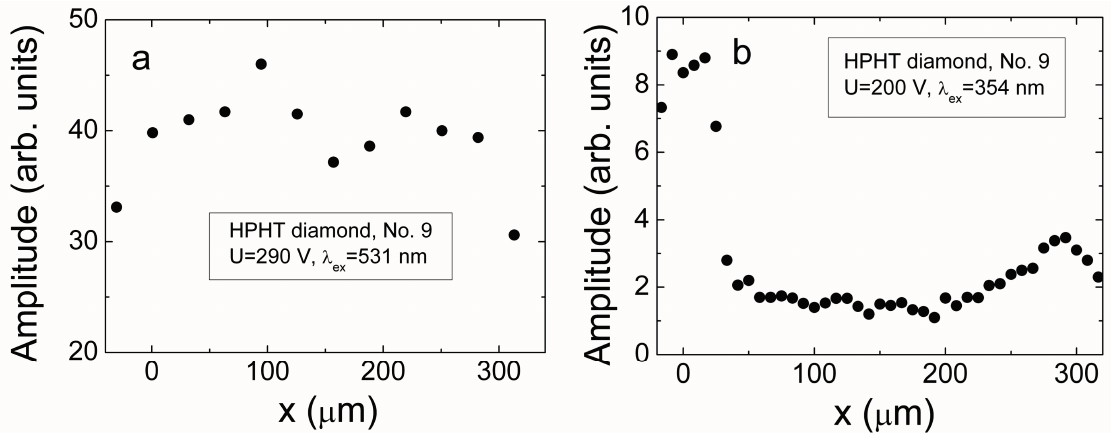
Figure 11. The cross-sectional profiles of the peak values of current induced by scanning location of a focused injection beam of 531 nm ( a ) and 354 nm ( b ) light, obtained for HPHT diamond sample No. 9.